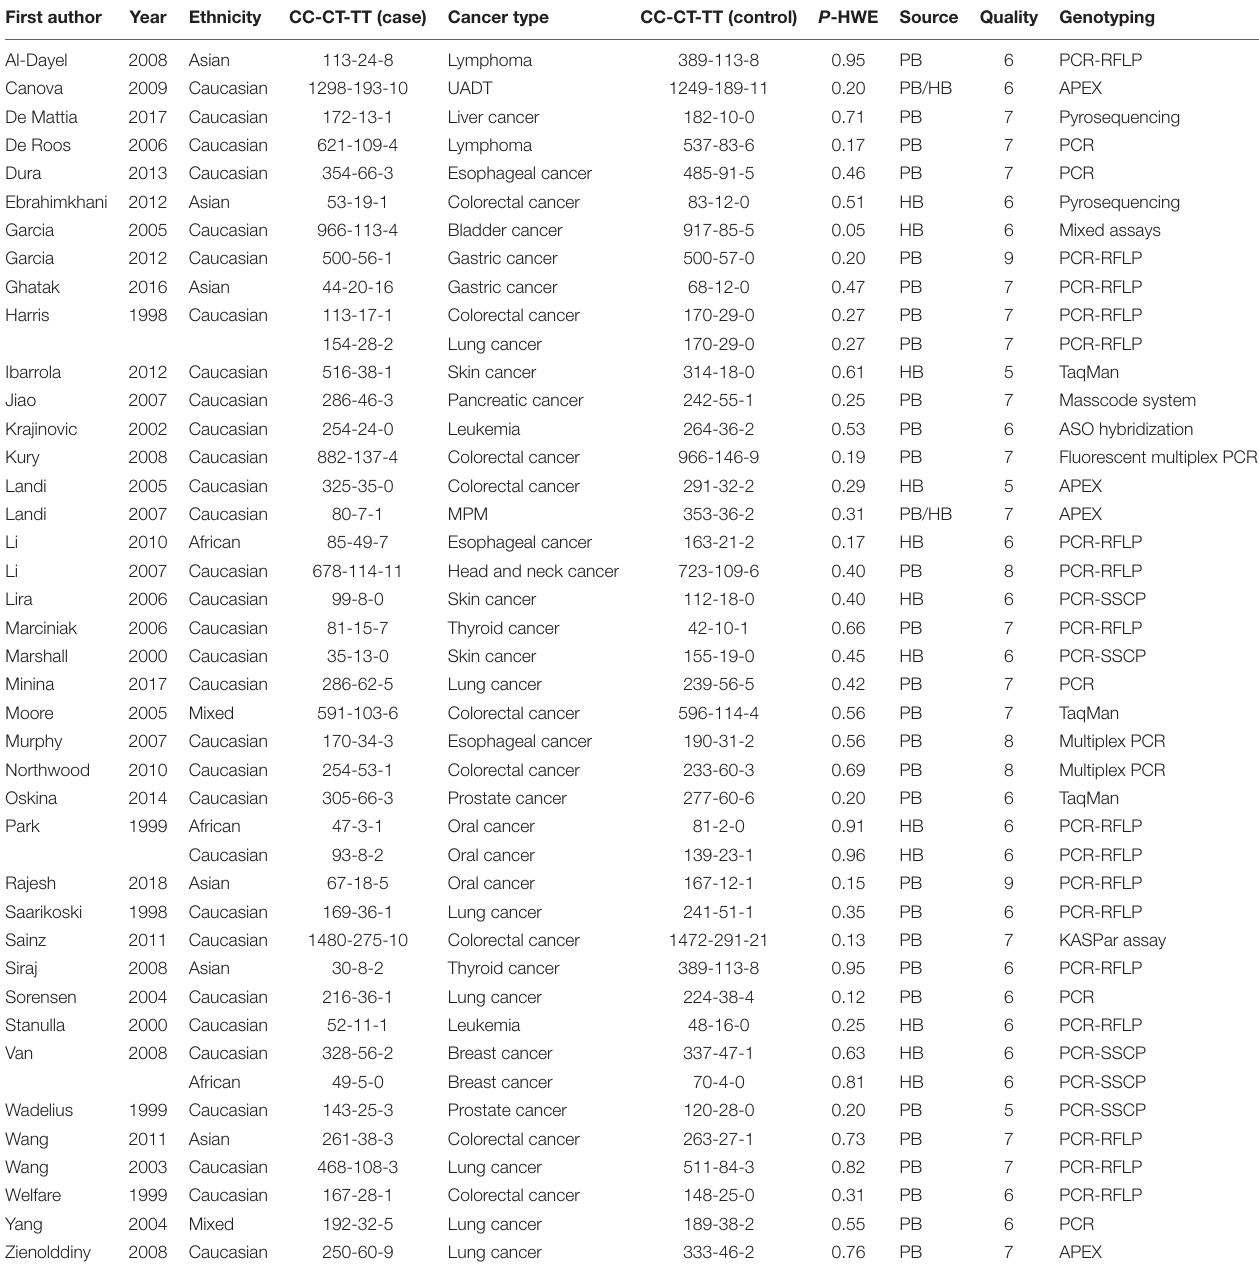
TABLE 1 | Characteristics of the included